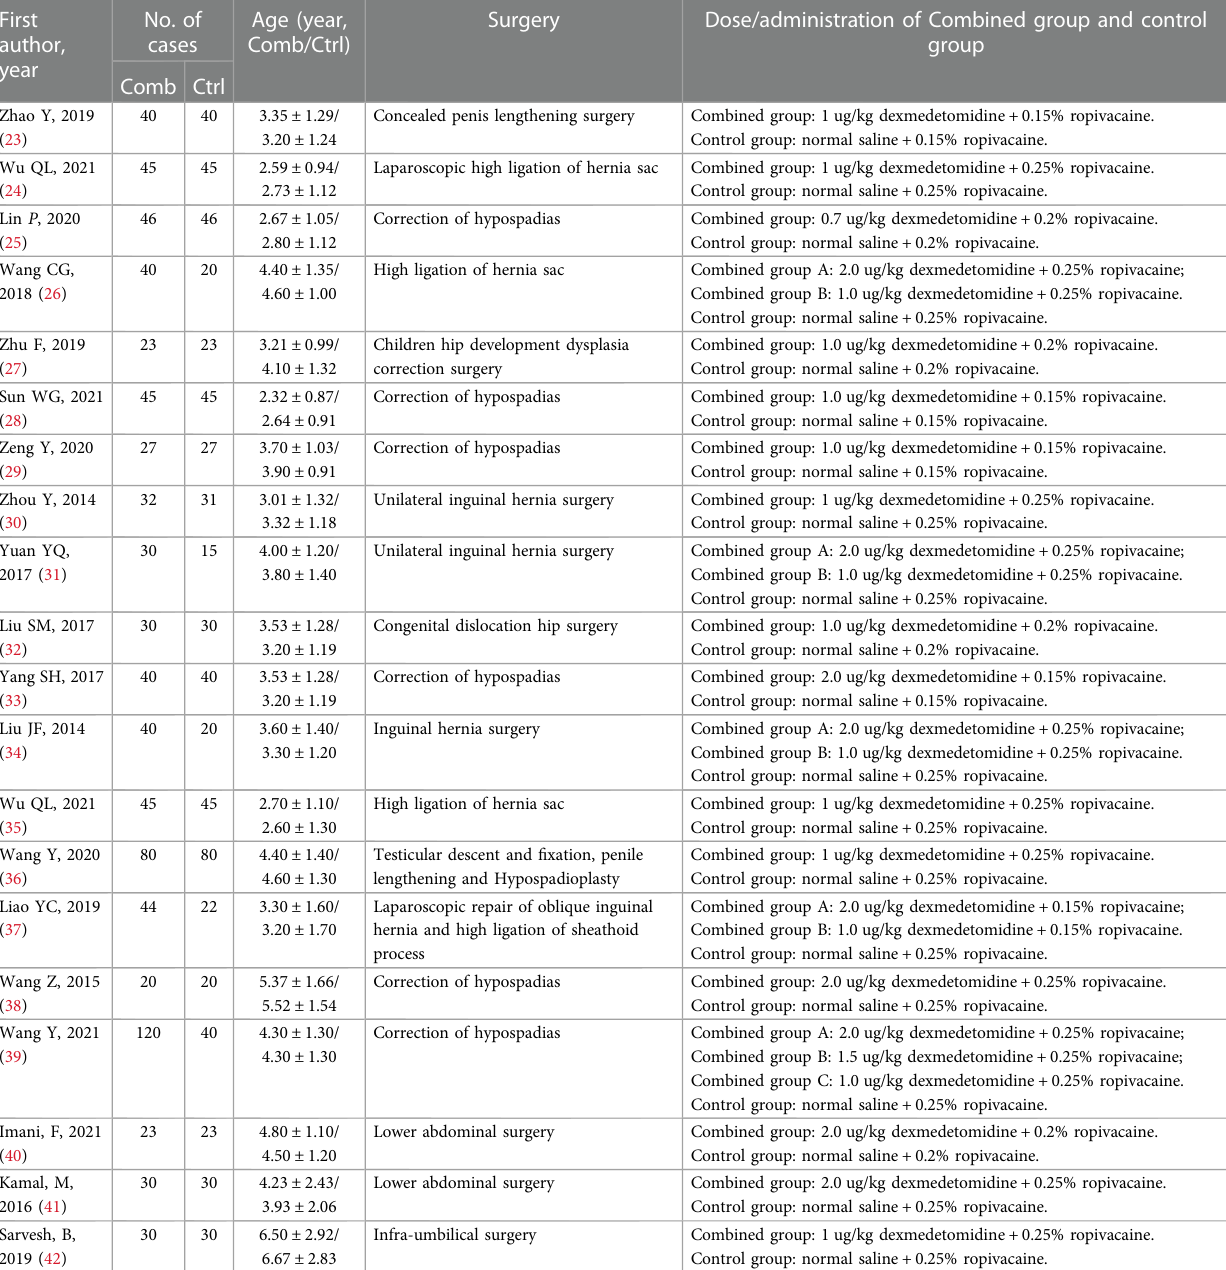
TABLE 1 Baseline characteristics of included studies for